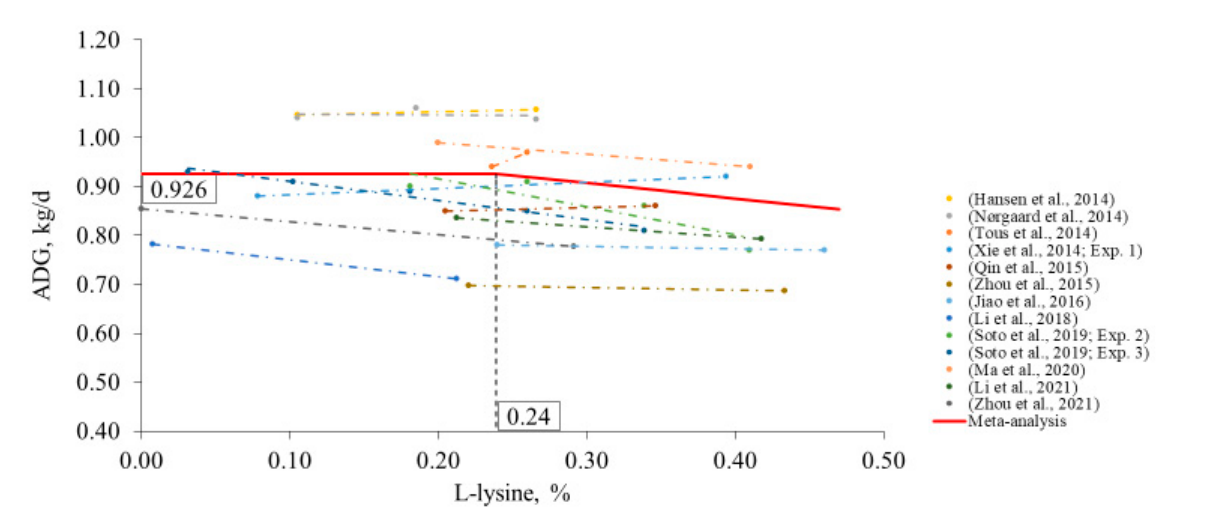
Figure 6. Changes in ADG in response to L-lysine supplementation in the finishing phase using a broken-line analysis. The L-lysine axis is based on 100% purity, calculated from L-lysine HCl (78.8% purity) or L-lysine sulfate (60.0% purity). The equation was ADG = 0.926 + 0.314 × zl (R 2 = 0.97) and the breakpoint was L-lysine level at 0.24% (95% CI: 0.10–0.37) when ADG was 0.926 kg/d. The p -value for the asymptote was <0.001, for the slope it was 0.033, and for the breaking point it was 0.002. Where, if L-lysine is ≤ breakpoint, then z1 = 0; if L-lysine is >breakpoint, then z1 = L-lysine −